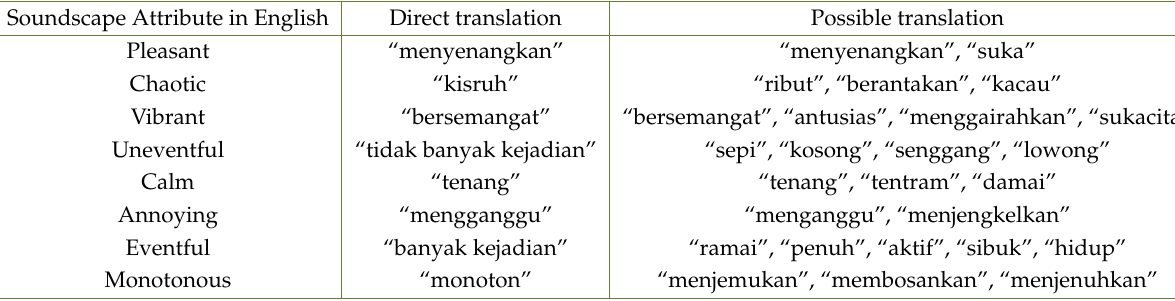
Table 1. Direct Translation and Possible Translation of Soundscape Attributes.